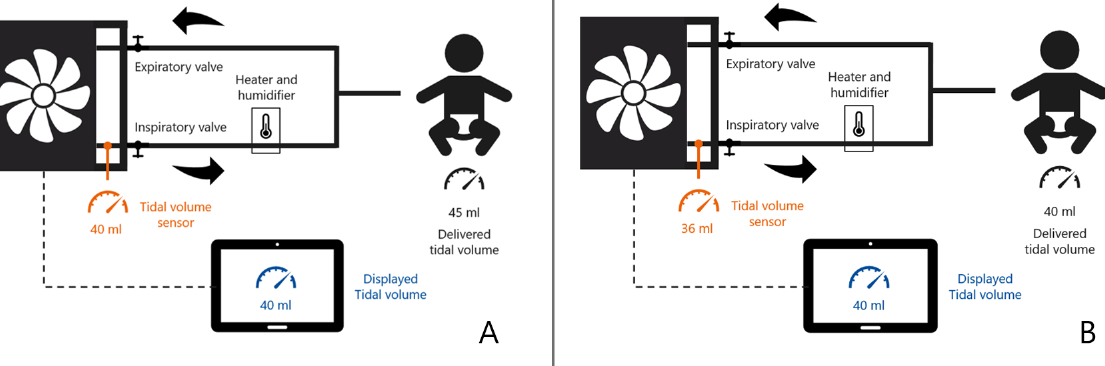
Figure 1. Schematic example of a ventilator displaying tidal volume (V T ) under ATPD ( A ) versus BTPS ( B ) conditions in a ventilated infant. In ( A ), inspiratory V was sensed and displayed as 40 mL, however, after heating and humidifying of the gas, the actual delivered V T was 45 mL. In ( B ), inspiratory V T was sensed as 36 mL, but after a (software) correction displayed and delivered as 40